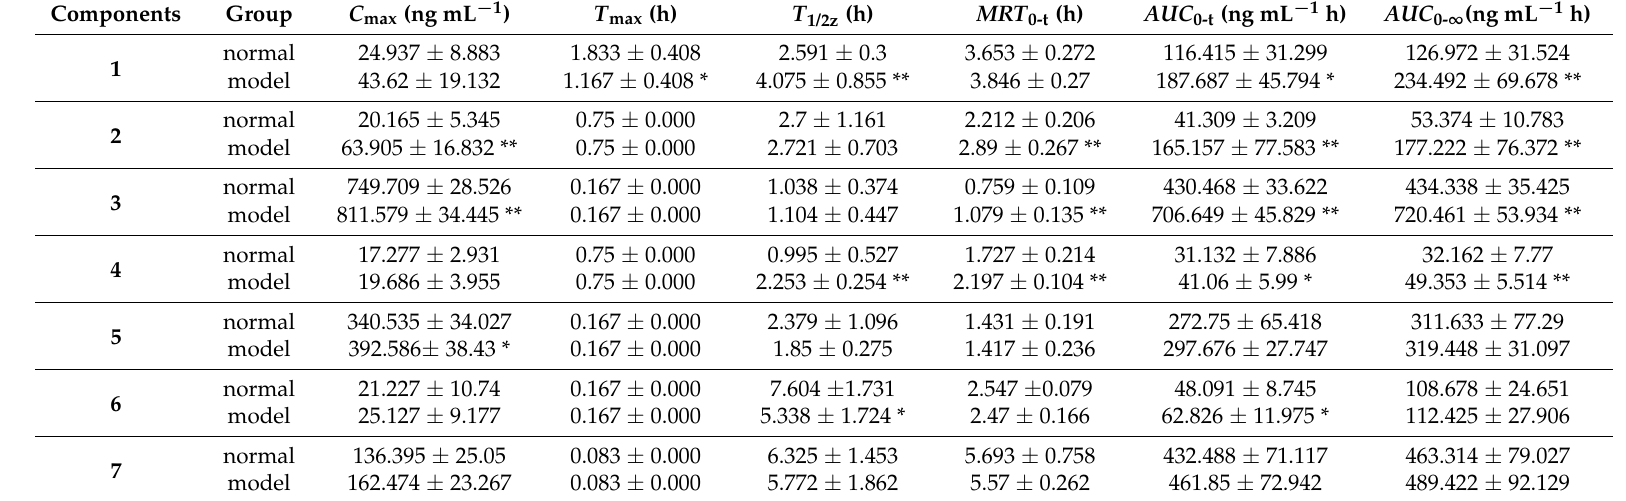
Table 4. NCA pharmacokinetic parameters of seven components of Gui-Hong extracts between normal and blood stasis rats ( n = 6).